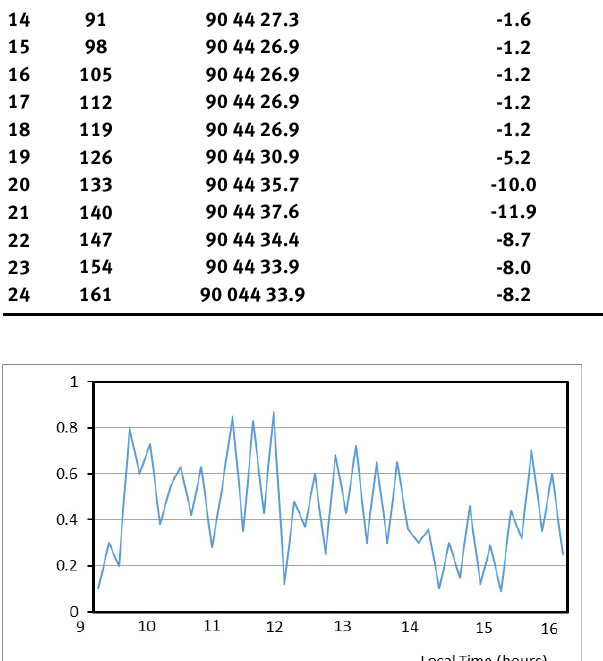
Fig. 3. Time series of structure refractive index constant C about eight hours in June 2019 for line of 625.22 m. The weather was sunny and the temperature was in the range from 20 ◦ C to 22 ◦ C. The wind speed did not exceed 2.9 m/s.